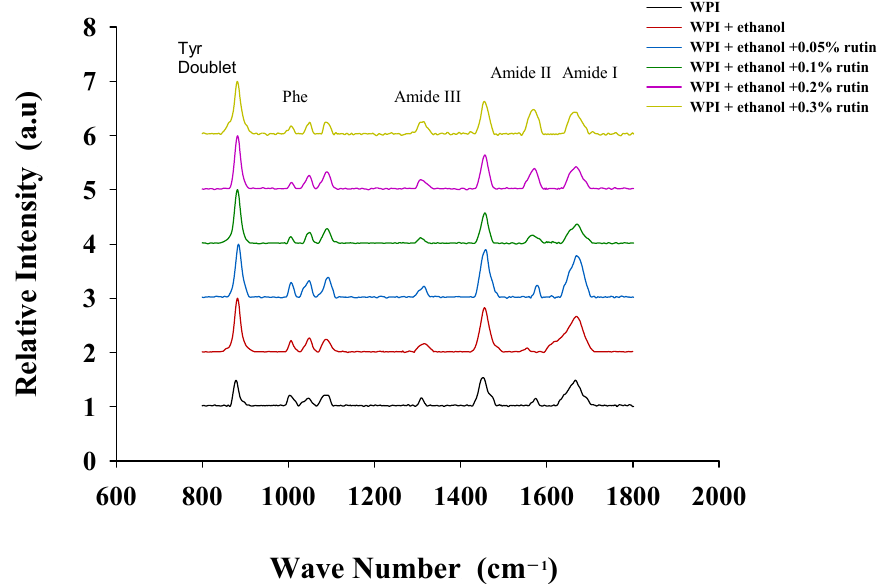
Figure 3. The effects of ethanol (15% v / v ) and different levels of rutin (0.05%, 0.1%, 0.2% and 0.3% w / v ) on the Raman spectrograms of WPI. Table 1. The effects of ethanol (15% v / v ) and different levels of rutin (0.05%, 0.1%, 0.2% and 0.3% w / v ) on the secondary structure of WPI. Means in the same row with different letters (a–d) differ significantly ( p < 0.05).